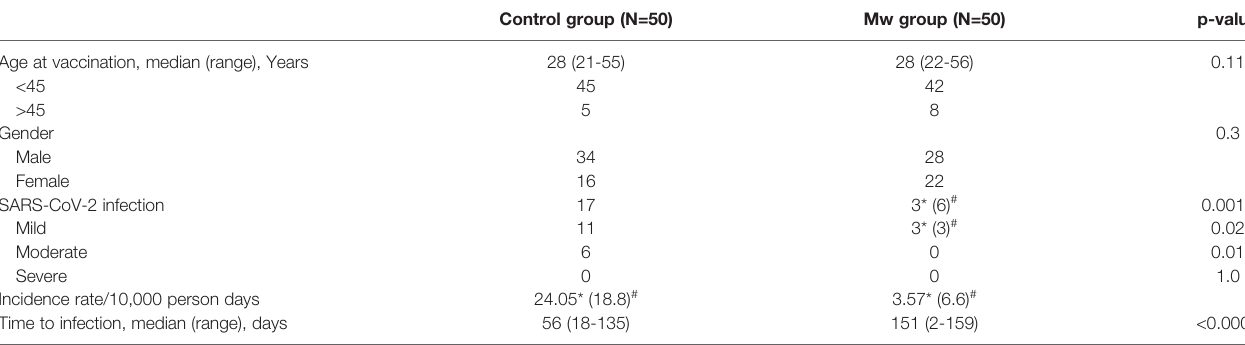
TABLE 1 | Characteristics and outcomes.